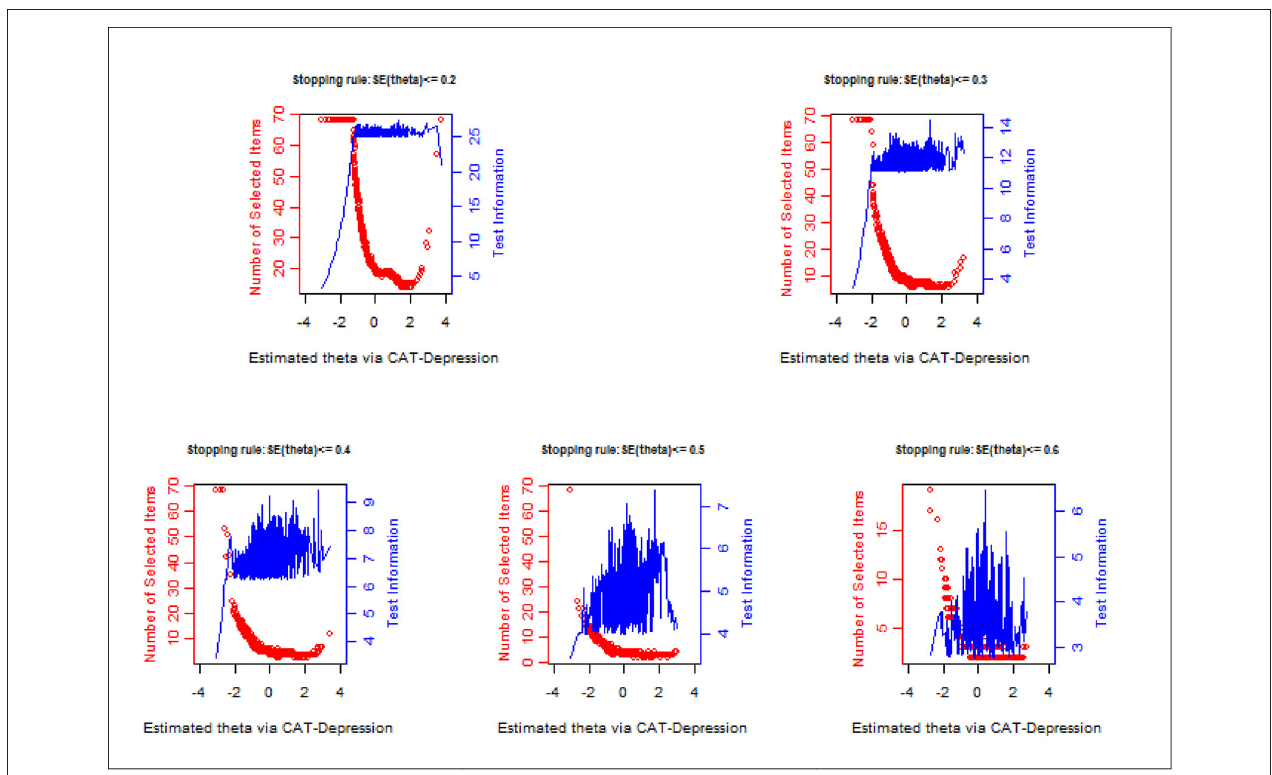
FIGURE 1 | Number of selected items and test information curve under different stopping rules.